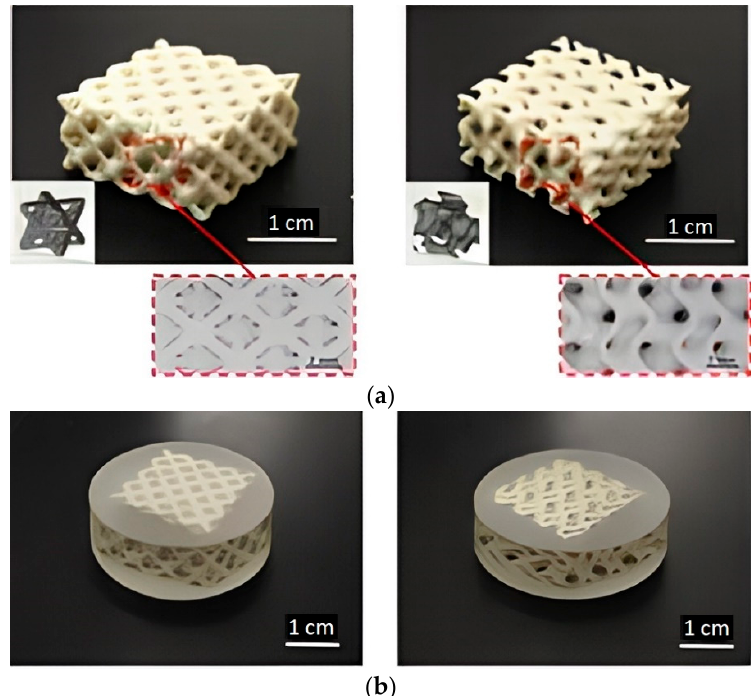
Figure 11. ( a ) Complex structures, octet-truss (left) and gyroid (right) of FGP fabricated by DLP method; ( b ) Piezoceramic/epoxy composites (Reprinted from Ref. [81], copyright (2021), with the kind permission of Elsevier